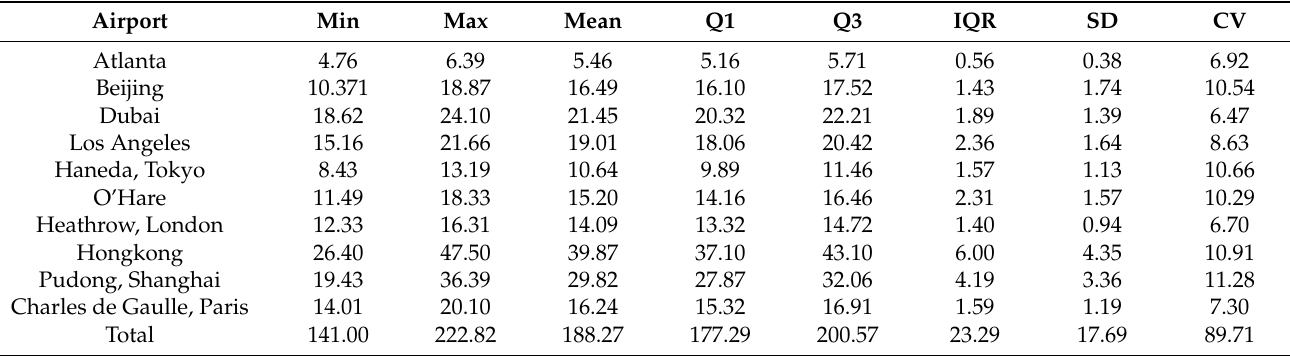
Table 1. Statistics on the freight volume of the top ten